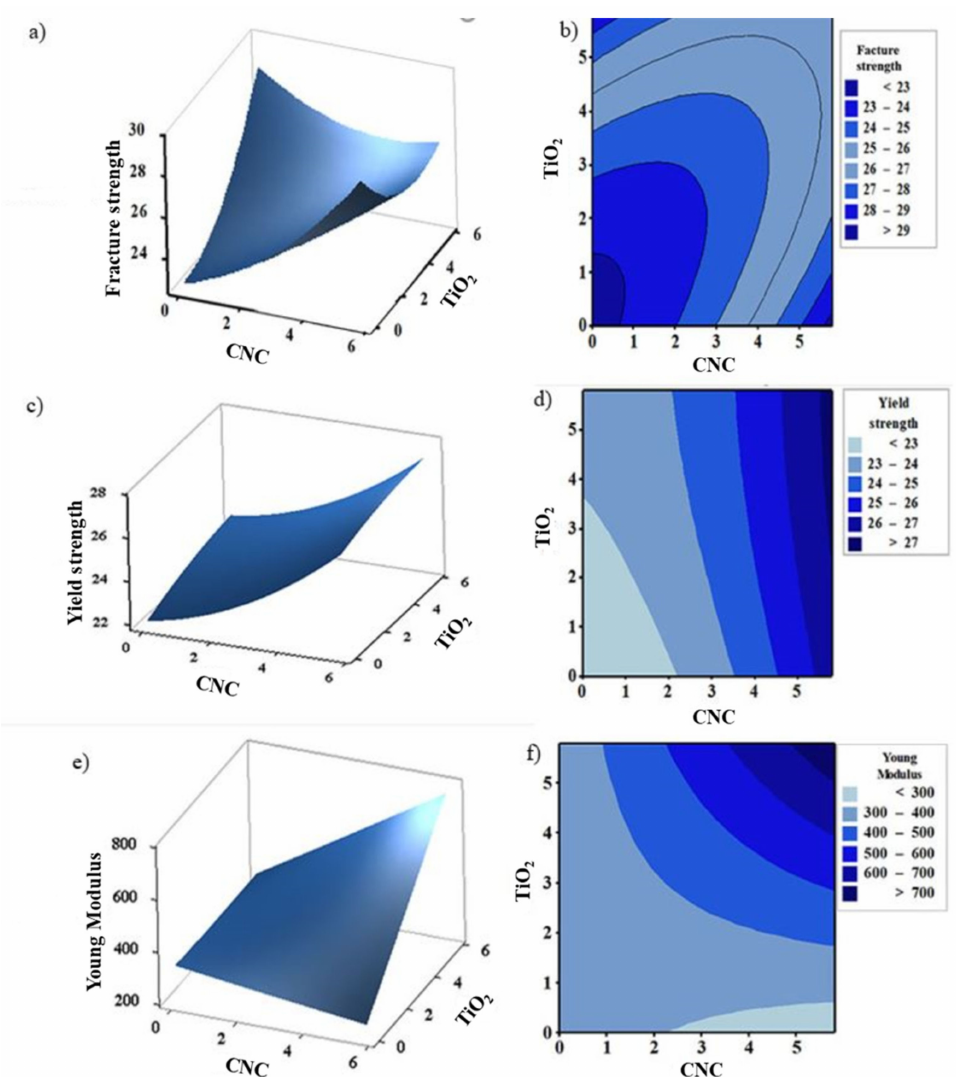
yield strength (c,d), and Young’s modulus (e,f)) modeled by the RSM-GA. As observed in Figure 11a,b, the incorporation of 1.0 wt.% of n-TiO 2 and 5.74 wt.% CNCs to the polymer matrix produced the maximum yield strength of 23.9 Mpa, whereas the highest value of fracture strength was obtained as 23.6 MPa by combining HDPE with 0.03 wt.% n-TiO 2 and 5.74 wt.% of CNCs (shown in Figure 11c,d). The maximum Young’s modulus achieved was 327 MPa when the concentration of TiO 2 and CNCs were used at 0.04 wt.% and 0.60 wt.%, respectively (Figure 11e,f). The R 2 for the regression equations for FS, YS, and YM were found to be 68.52%, 91.14%, and 49.17%, respectively. Although R 2 is recommended to be higher than 95% to achieve better-predicted data, our data could not achieve such a value. This could explain the difference between the experimental and predicted results [71,72].